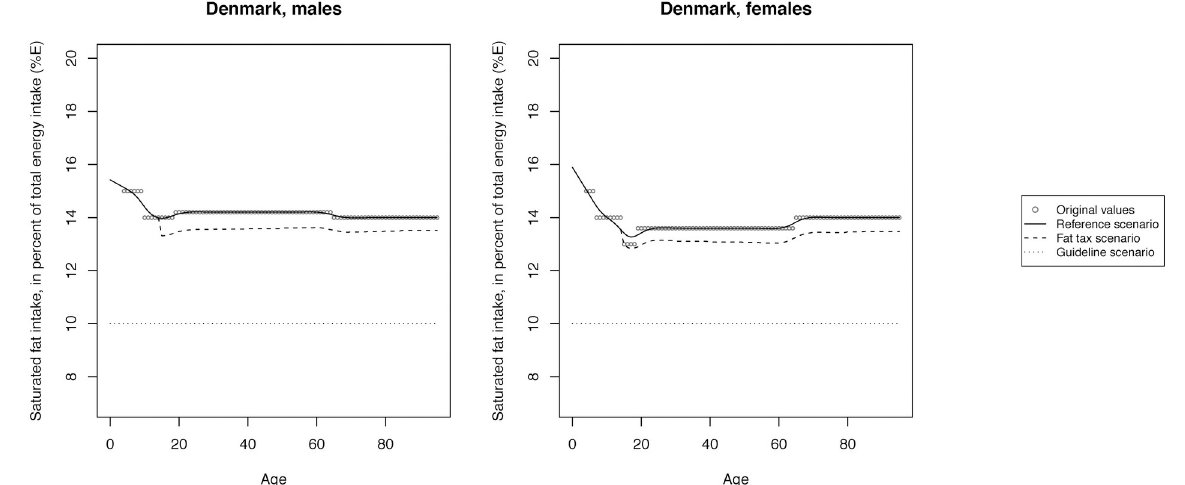
Fig 2. Mean saturated fat intake across reference, fat tax and guideline scenario in